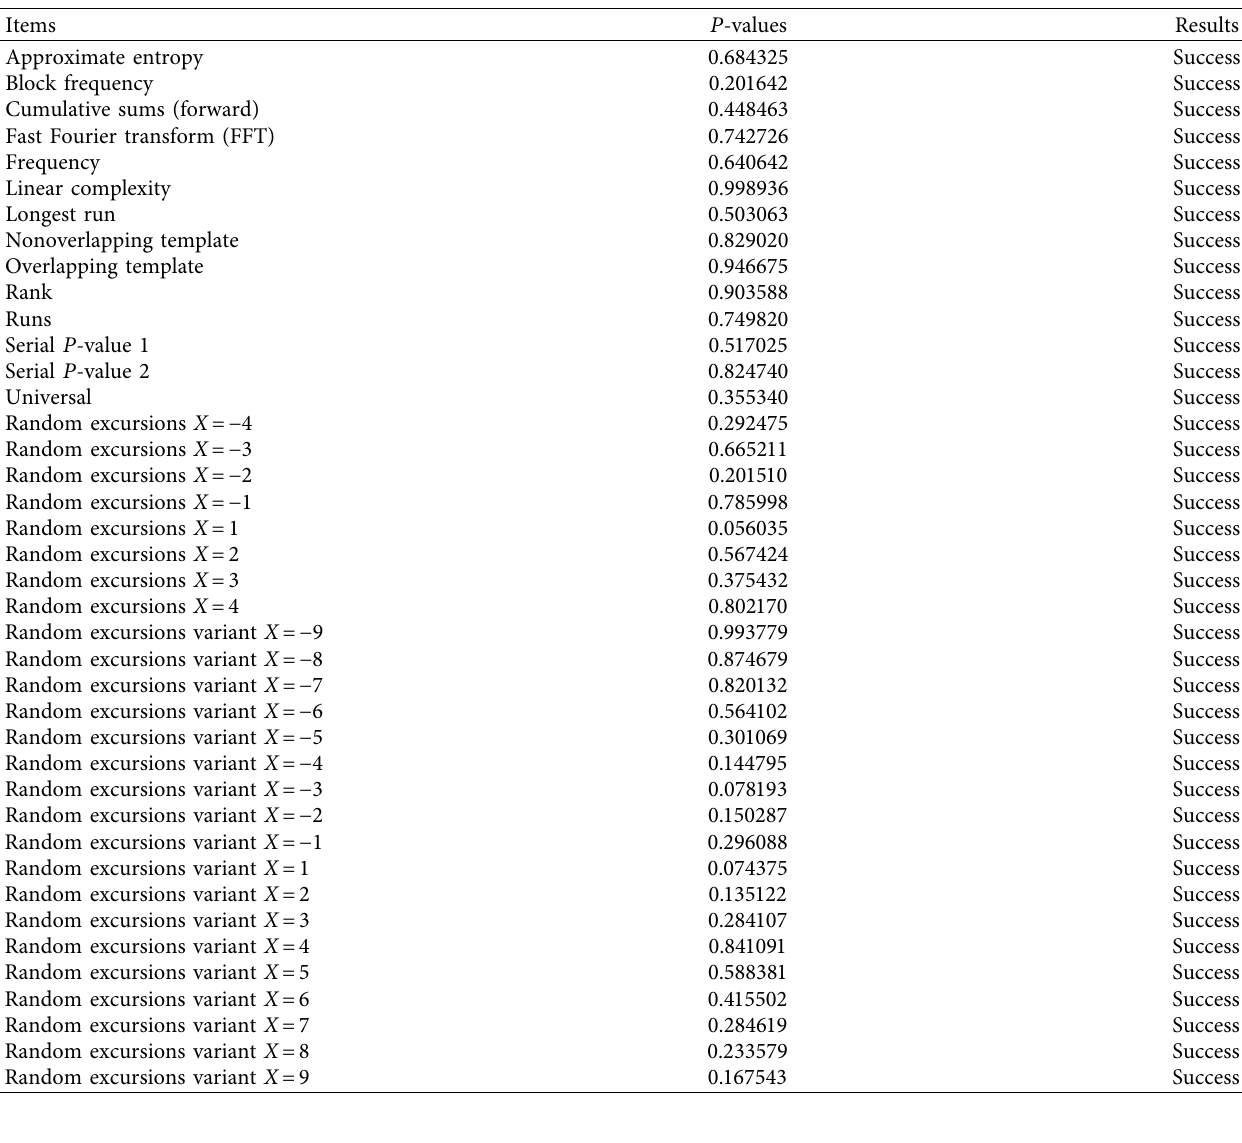
Table 1: Results of a randomness